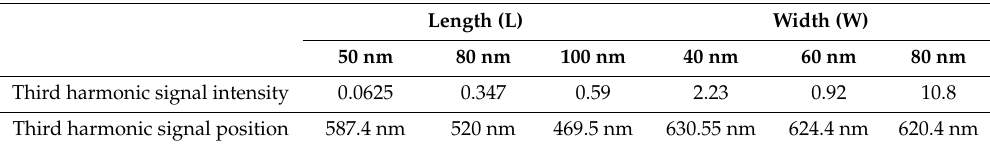
Figure 5. The third harmonic emission spectrum of ( a ) a-GST and ( b ) c-GST conditions for the variations in W: ( i ) 40 nm, ( ii ) 60 nm, and ( iii ) 80 nm. Table 1. Effect of the geometric variations in the structural parameters on the generated third harmonic signal intensity and position for a-GST.